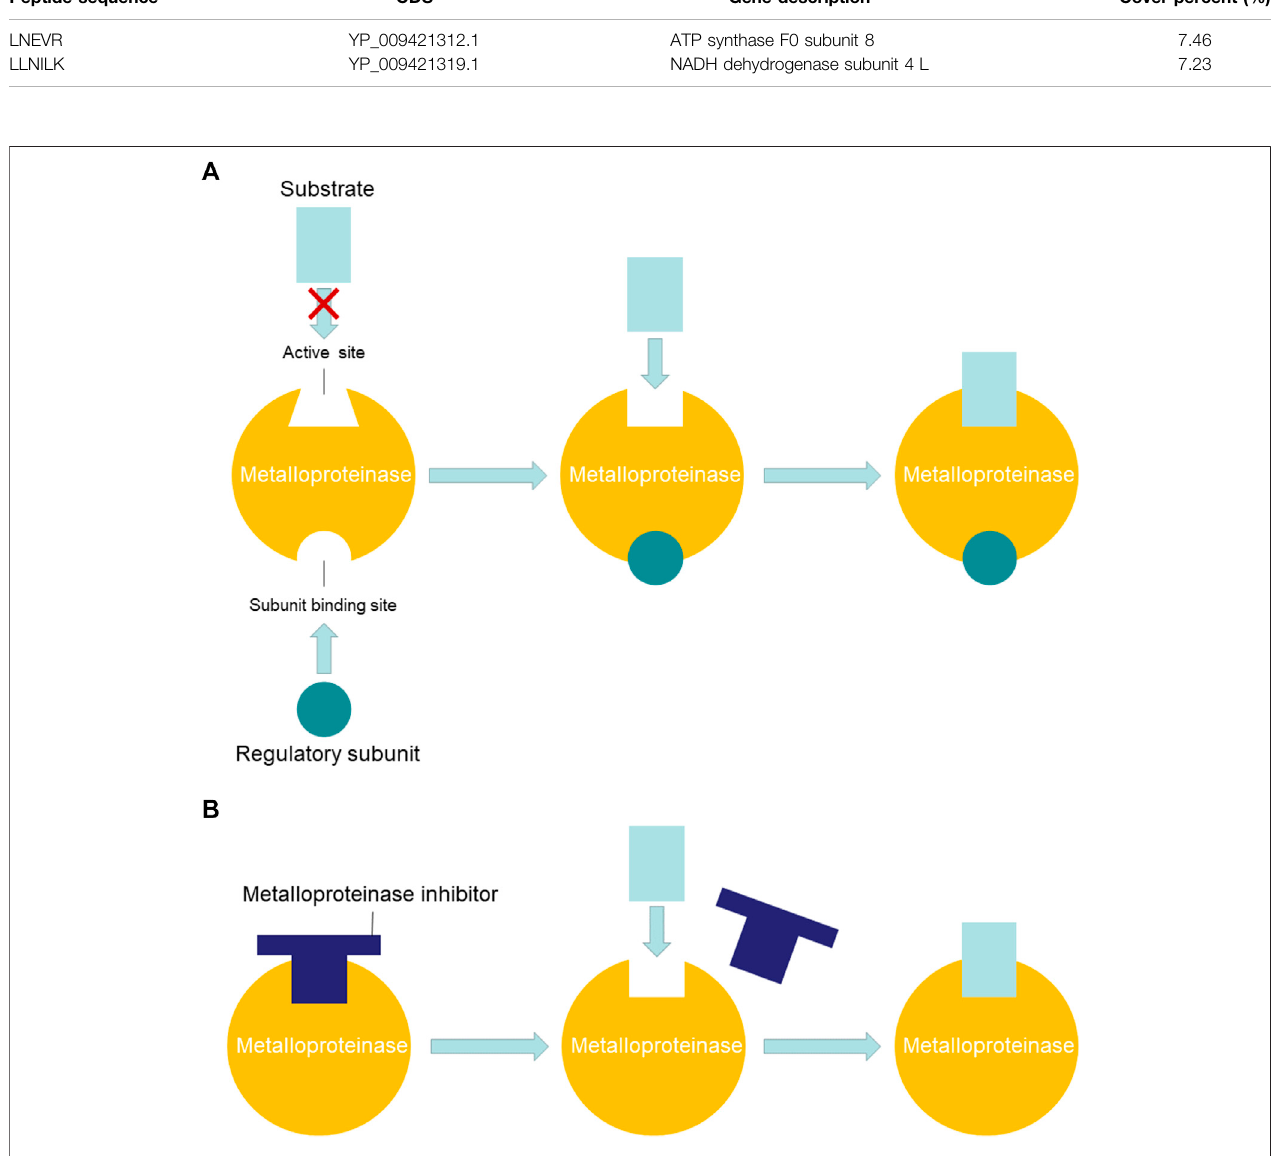
FIGURE 6 | Possible regulation mechanisms of NnVMP activity. (A) Metalloproteinase was activated by binding regulatory subunit. (B) Metalloproteinase was activated by disengaging inhibitor.